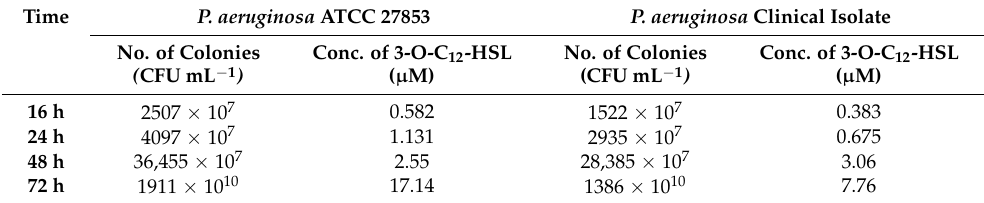
Table 6. P. aeruginosa cultures analysis.